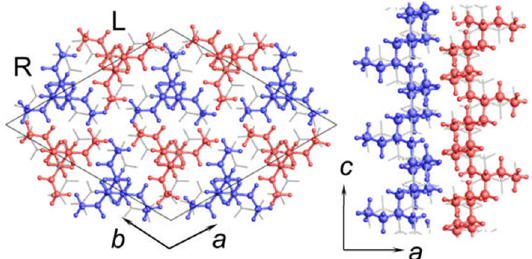
Figure 1. Crystal structure of iPBu form I looking along the c - ( left ) and b -axes ( right ), respectively. Reproduced with permission from Ref. [23], copyright 2016 American Chemical Society. Reproduced with permission from Ref. [23], copyright 2016 American Chemical